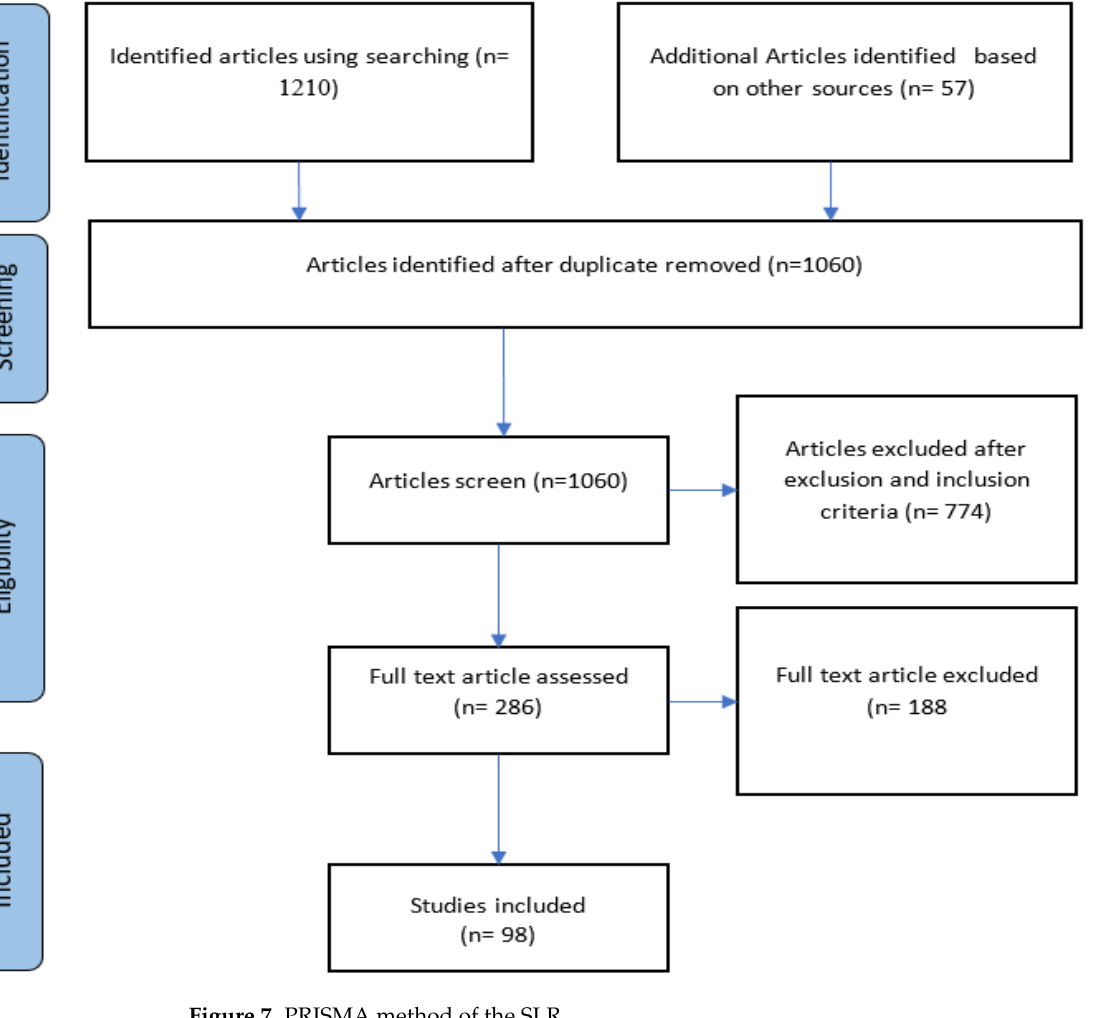
Figure 7. PRISMA method of the SLR.